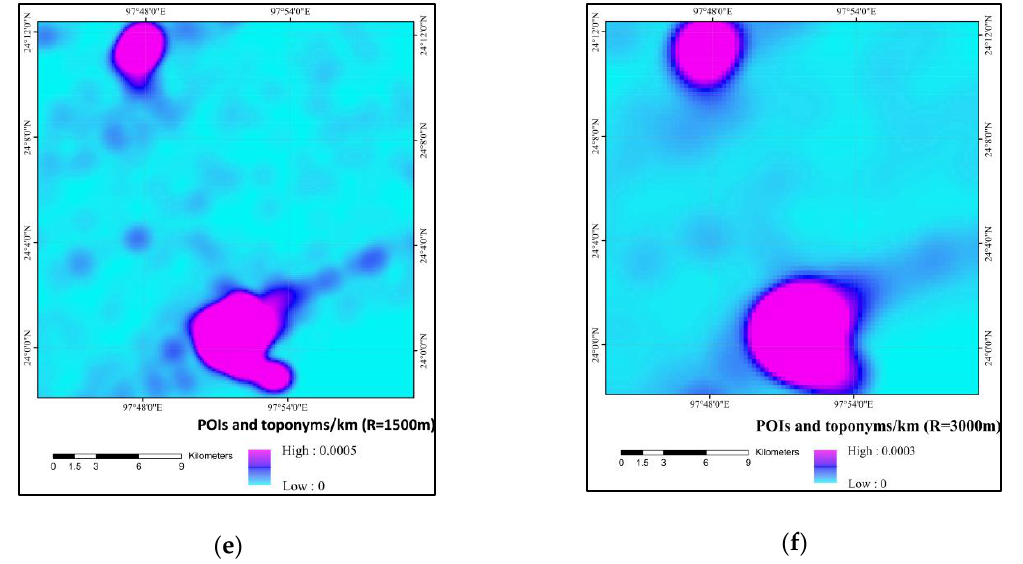
Figure 4. The results of kernel density estimation (KDE) at different bandwidths: ( a ) Results of KDE when the bandwidth is 300 m; ( b ) Results of KDE when the bandwidth is 500 m; ( c ) Results of KDE when the bandwidth is 800 m; ( d ) Results of KDE when the bandwidth is 1000 m; ( e ) Results of KDE when the bandwidth is 1500 m; ( f ) Results of KDE when the bandwidth is 3000 m.